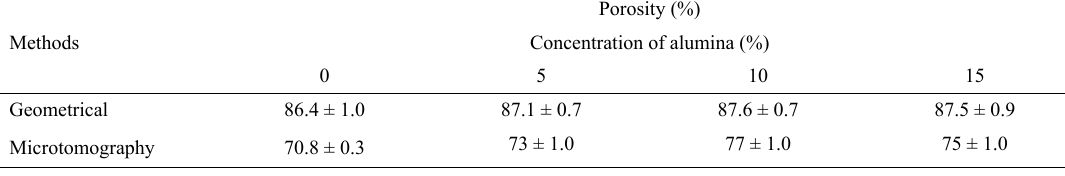
O scaffolds. 2 3